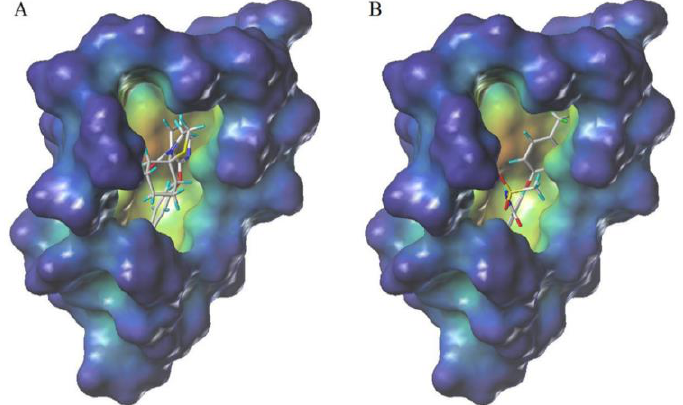
Figure 5. The receptor-ligand interaction of fomesafen ( A ) and compound 4i ( B ) with the PPO active site.